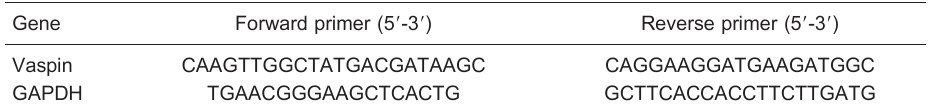
Table 1. Primer sequences for real-time